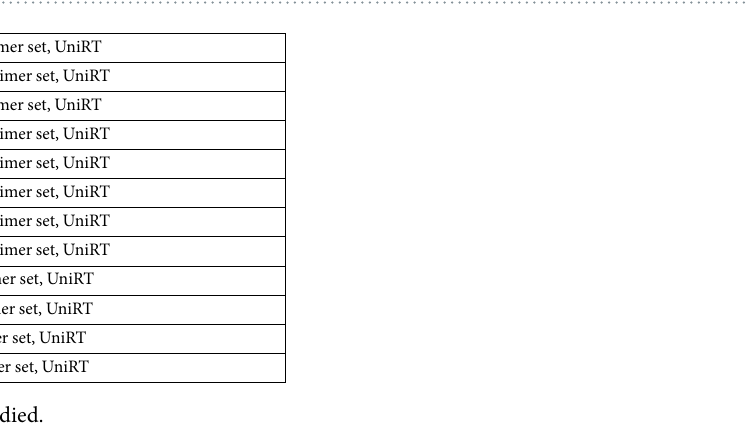
Figure 1. ( A ) Representative curves of DLS assays performed for the 4 isolation methods (I) TF-AF, (II) TF- BF, (III) EX-AF and (IV) EX-BF and the mean diameters obtained. ( B ) Representative Western blot bands of the exosomal proteins HSP70 and CD63 displayed on their individual Western blot assays. ( C ) Representative exosome images taken by electron microscopy (I) TF-AF, (II) TF-BF, (III) EX-AF and (IV) EX-BF.